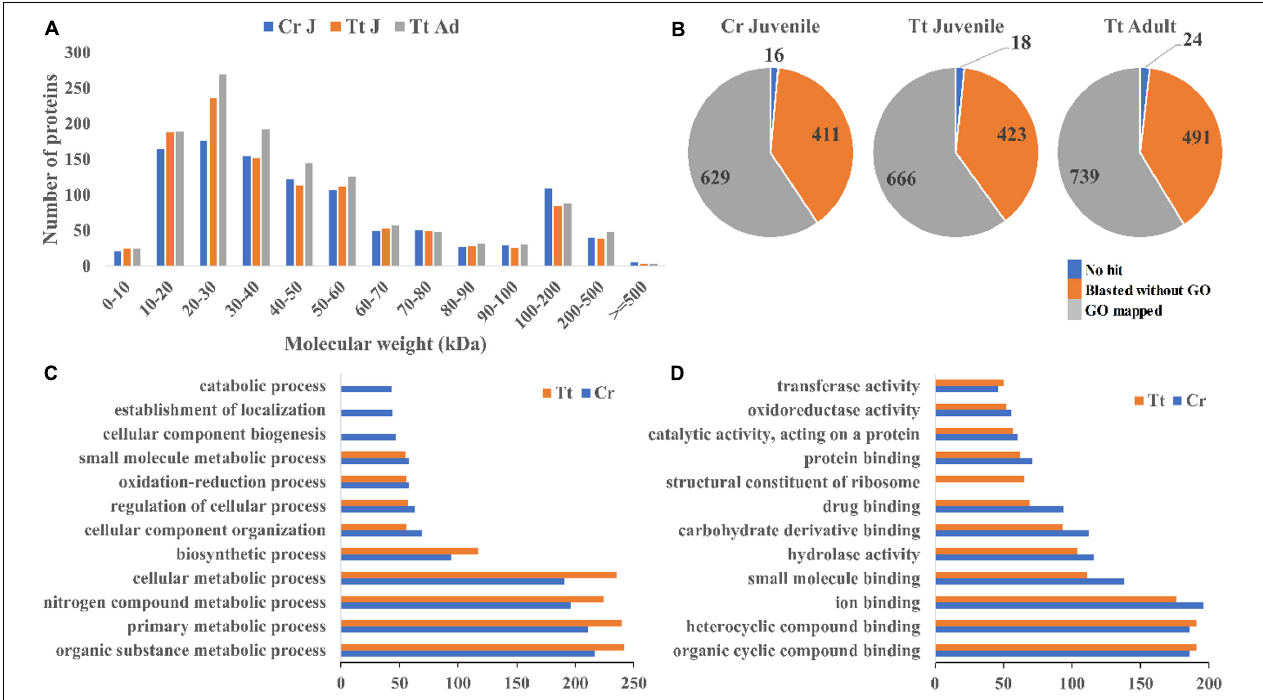
FIGURE 1 | Landscape of the proteins detected in the hemolymph of C. rotundicauda (Cr) and T. tridentatus (Tt). (A) Size distribution of detected hemolymph proteins; (B) Protein numbers with the blast and functional annotation (GO) results in Cr juvenile (Cr J), Tt juvenile (Tt J), and adult (Tt Ad) hemolymph respectively; (C,D) Level 3 Gene ontology ( GO) terms distribution based on biological processes (C) and molecular function (D) of juvenile C. rotundicauda and T. tridentatus hemolymph